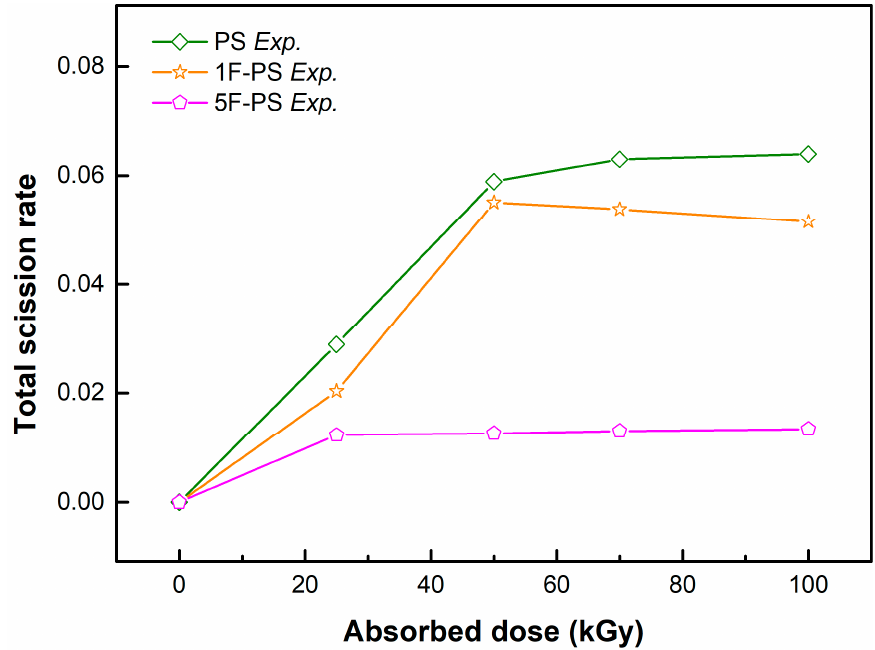
Figure 10. The polymers normalized average molecular weight after irradiation (experiment results).